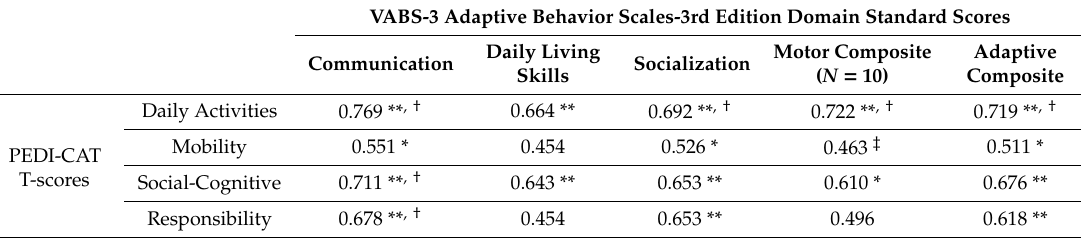
Table 3. Convergent and divergent validity: Spearman’s rho correlation coe ffi cients.